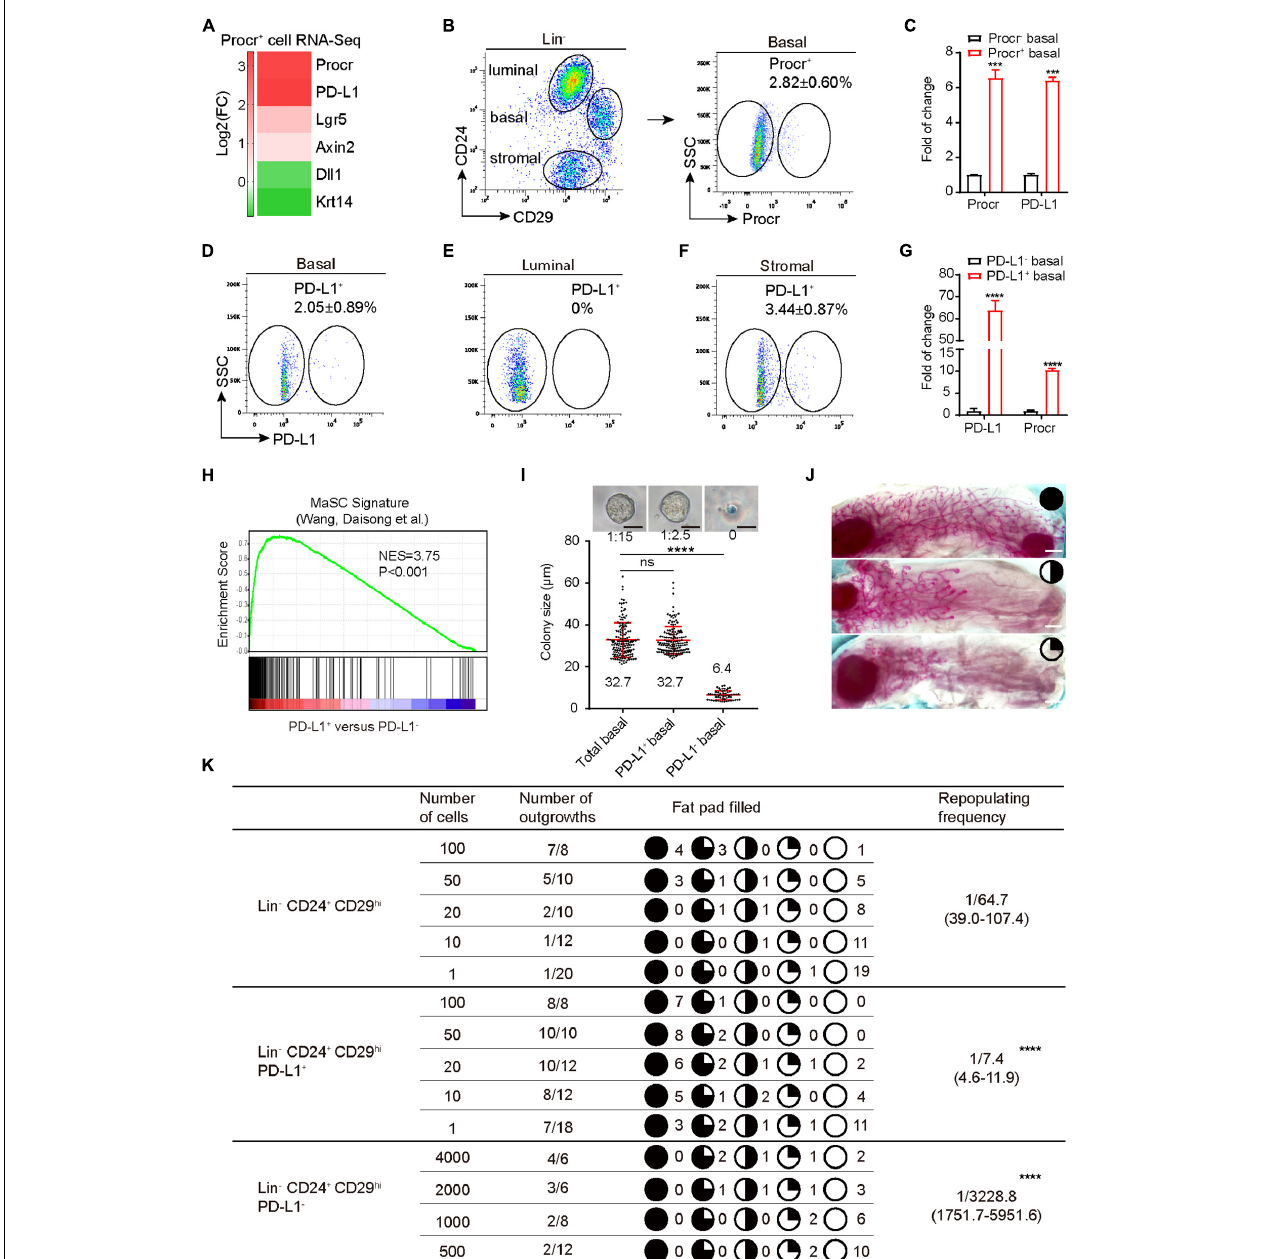
FIGURE 1 | PD-L1 labels a subset of mammary basal cells with high regeneration capacity. (A) PD-L1 expression was enriched in Procr + MaSCs (Procr + mammary basal cells). Heat map analysis for Procr + MaSCs compared with Procr − basal cells. (B) Isolation of Procr + MaSCs by FACS. (C) Real-time quantification PCR (qPCR) analysis of PD-L1 mRNA levels in Procr + basal and Procr − basal cells, with GAPDH as an internal control. Data are presented as mean ± SD. Unpaired t -test: *** P < 0.001; n = 3 mice. (D–F) FACS analysis of PD-L1 expression in mammary glands of adult mice. PD-L1 + cells were distributed among basal cells (2.05 ± 0.89%) (D) , and stromal cells (3.44 ± 0.87%) (F) , no PD-L1 + cells were detected among the luminal cells (E) ; n = 3 mice. (G) Real-time quantification PCR (qPCR) analysis of Procr mRNA levels in PD-L1 + basal and PD-L1 − basal cells, with GAPDH as an internal control. Data are presented as mean ± SD. Unpaired t -test: **** P < 0.0001; n = 3 mice. (H) GSEA demonstrating enriched gene signatures of Procr + MaSC in the PD-L1 + basal cells as compared to the PD-L1 − basal cells. (I) Colony formation efficiency and colony size of total (Lin − CD24 + CD29 hi ), PD-L1 + (Lin − CD24 + CD29 hi PD-L1 + ) and PD-L1 − basal cells (Lin − CD24 + CD29 hi PD-L1 − ) in 3D Matrigel culture. Data were combined from three independent experiments. Data are presented as the mean ± SD. Unpaired t -test: **** P < 0.0001. Scale bars, 50 µ m. (J) Representative images of different percentage of fat pad filled with regeneration mammary gland. Scale bars, 1 mm. (K) Regeneration efficiency of total (Lin − CD24 + CD29 hi ), PD-L1 + (Lin − CD24 + CD29 hi PD-L1 + ) and PD-L1 − basal cells (Lin − CD24 + CD29 hi PD-L1 − ). The